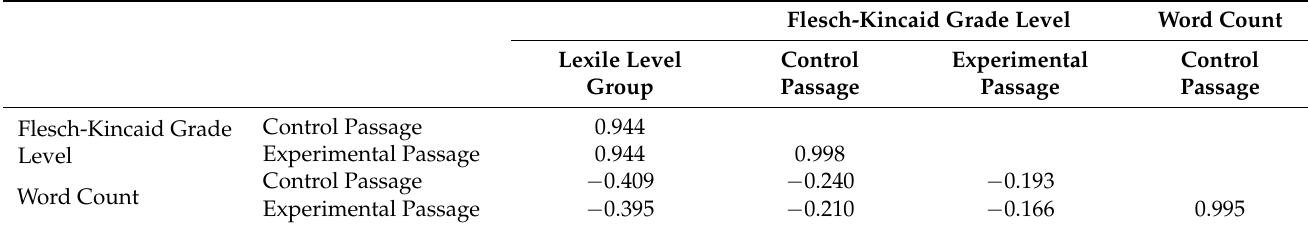
Table 2. Correlations Between Measures of Passage